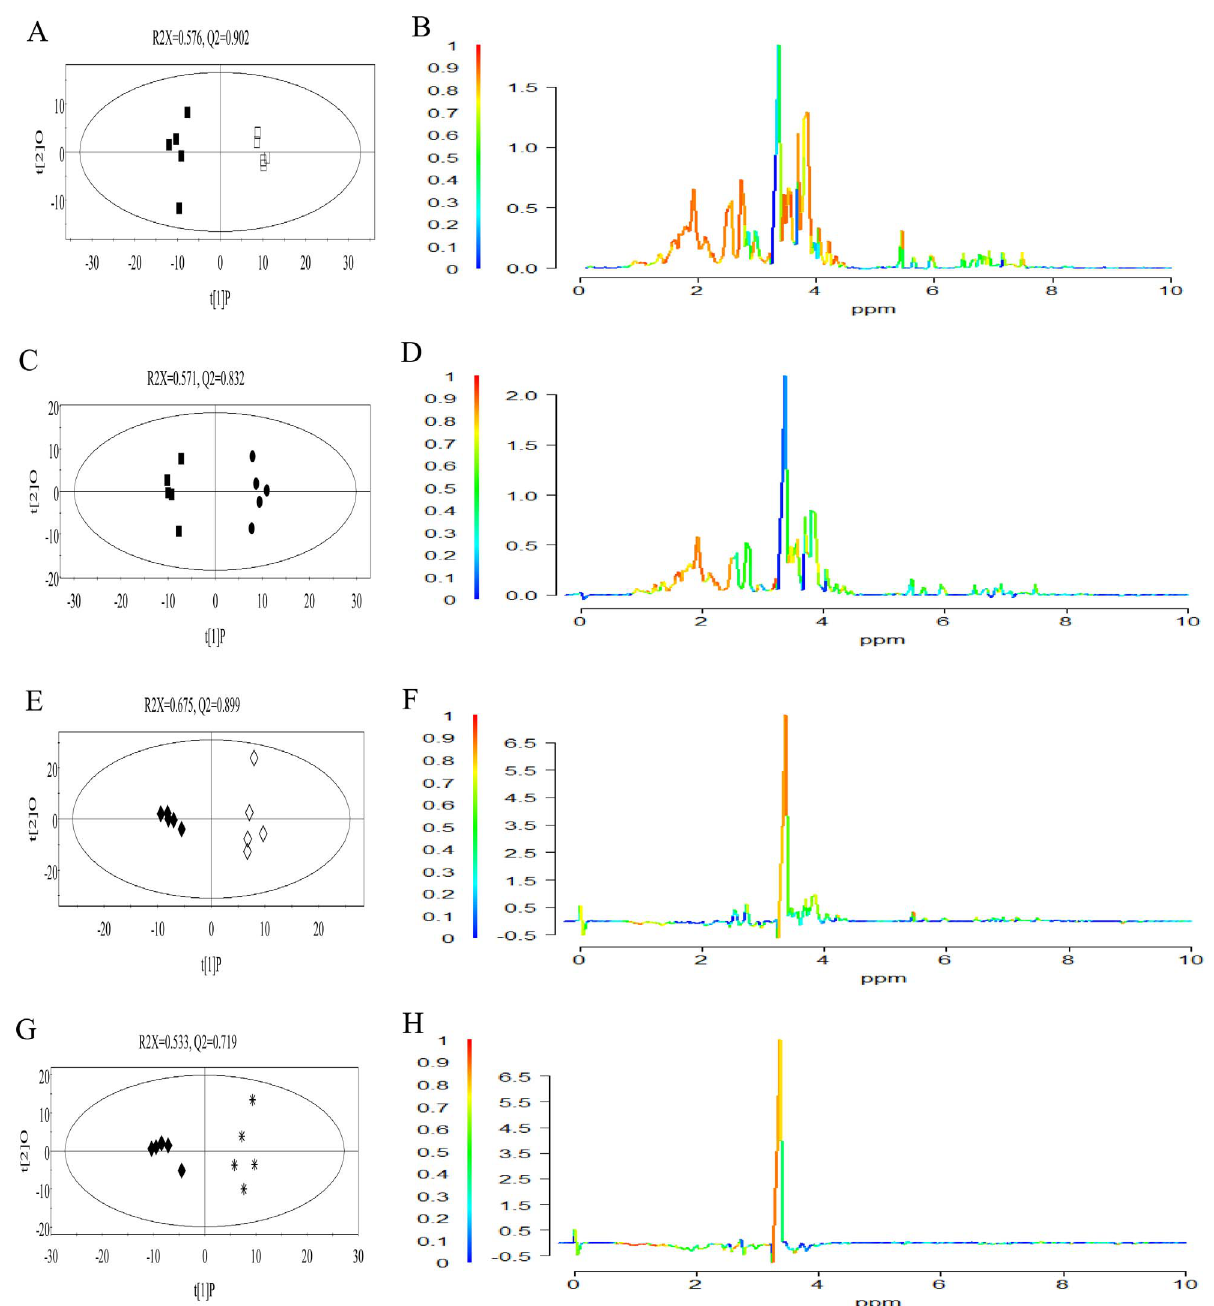
Figure 3. OPLS-DA score plots (left) and corresponding loading plots (right) of roots. A, B: OPLS-DA score and loading plots of roots from seedlings infested for 12 h versus control; C, D: OPLS-DA score and loading plots of roots from seedlings exposed to HIPVs for 12 h versus control; E, F: OPLS-DA score and loading plots of roots from seedlings infested for 24 h versus control; G, H: OPLS-DA score and loading plots of roots from seedlings exposed to HIPVs for 24 h versus control. Symbolization of samples in score plots were the same with figure 2. For coefficient-coded loading plots, horizontal axis corresponds to the integrated regions of 0.4–10.0 ppm in 1 H NMR spectra; vertical axis are the back transformed loading value and colors for variables (compounds) are coded by square of coefficients (r 2